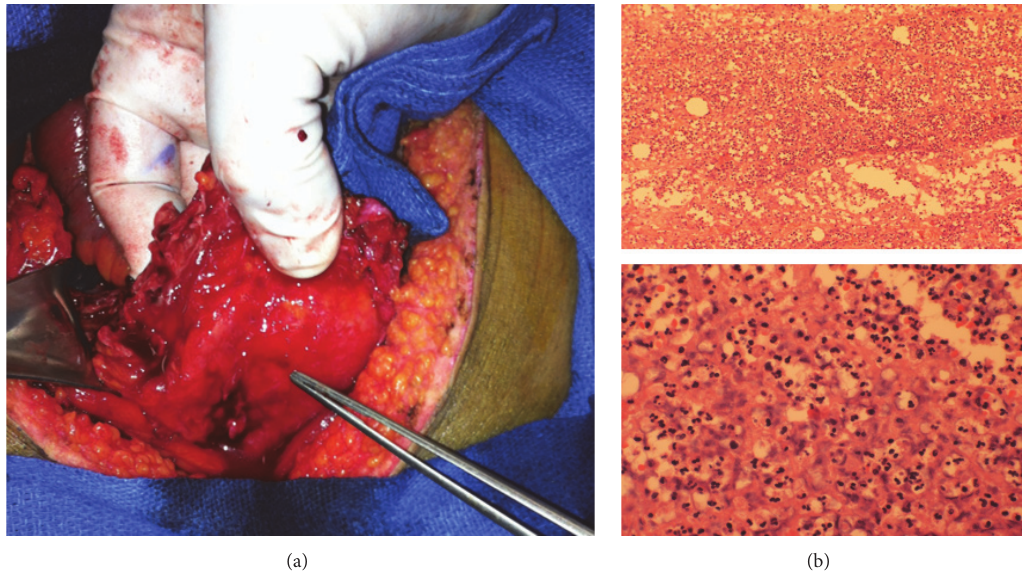
Figure 2: Intraoperative and pathology specimens showing anatomical and microscopic inflammatory findings consistent with urachal cyst as the etiology for small bowel obstruction. (a) Urachal cyst in the inferior right intraperitoneal cavity as the cause of small bowel obstruction. (b) Microscopic inflammation with severe